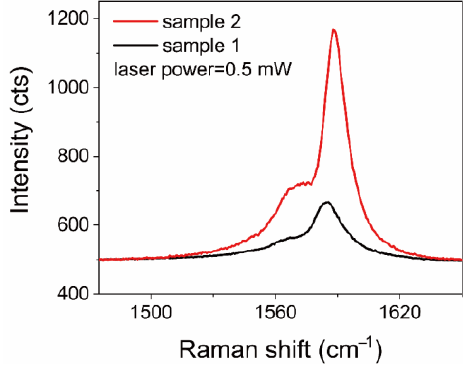
Figure 3. Raman spectra of Sample 1 and Sample 2.